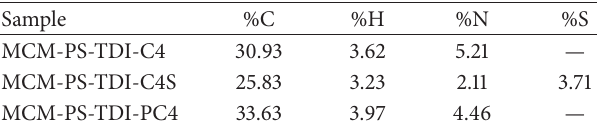
Table 3: Results of elemental analysis for MCM-PS-TDI function- alized with calix[4]arene derivatives.